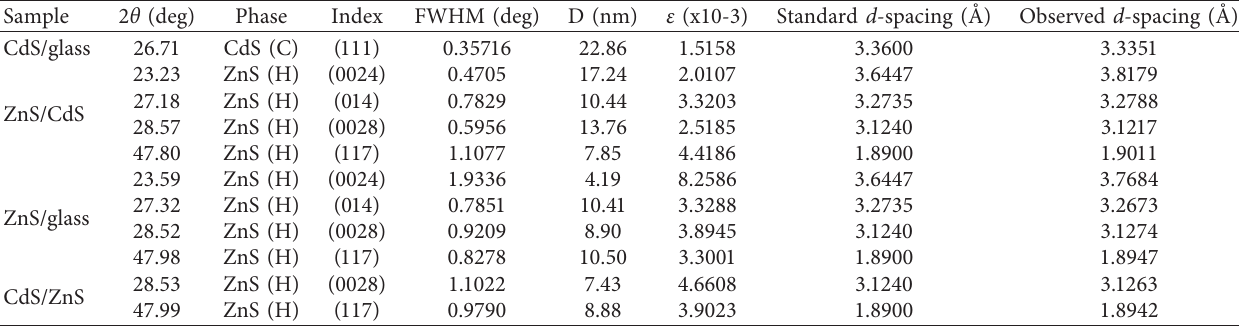
Table 1: Some standard, observed, and calculated structural parameters of CdS/glass, CdS/ZnS, ZnS/glass, and ZnS/CdS thin films (JCPDS # used 00-010-0454 for cubic CdS and 01-089-2174 for hexagonal ZnS). Sample 2 θ (deg)